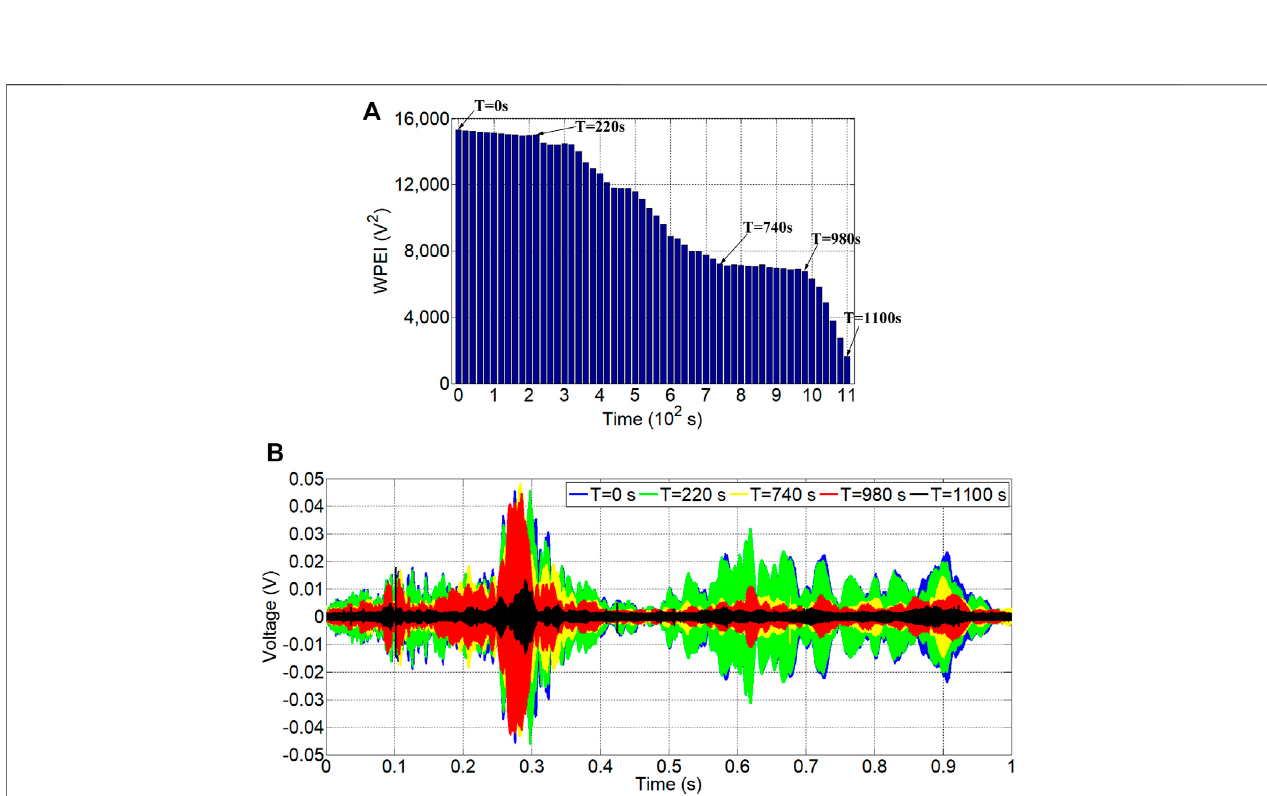
FIGURE 10 | WPEIs and received signal of S3: (A) WPEIs of the received signal; (B) the received stress wave signal.